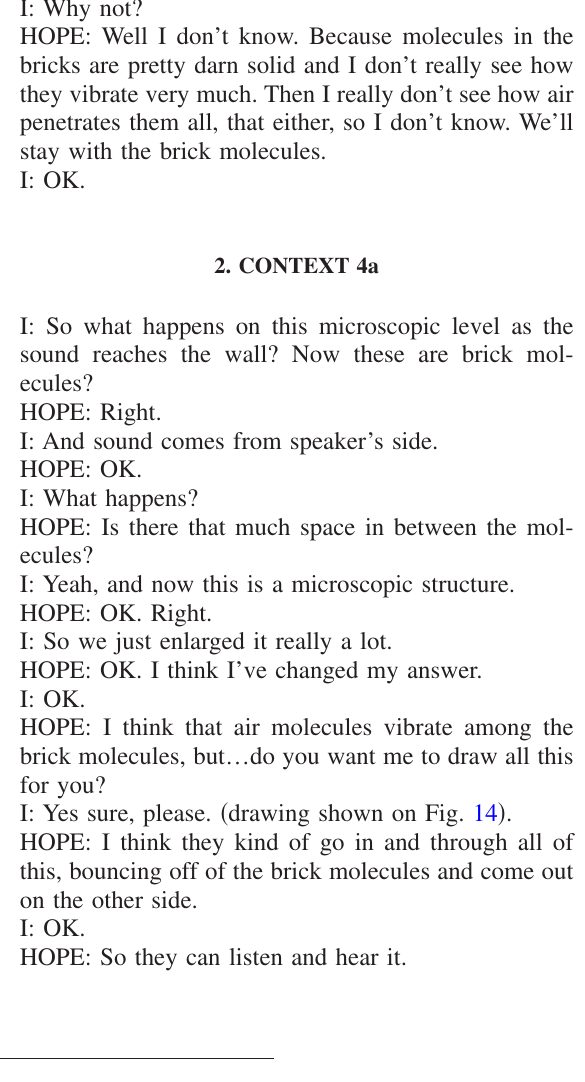
FIG. 13. Student’s drawing over provided template to illustrate the statement (cid:1) Jewel (cid:2) .